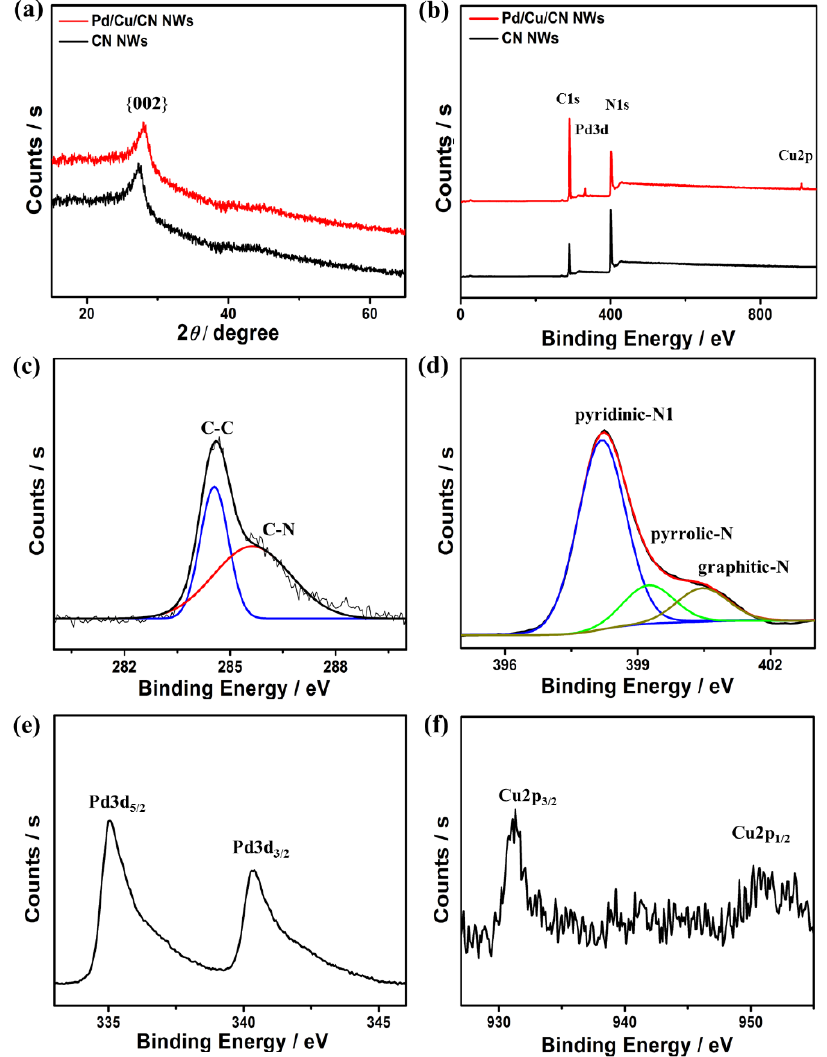
Figure 4. ( a ) Wide-angle XRD patterns; ( b ) XPS survey of Pd/Cu/CN NWs and CN NWs; ( c ) high resolution XPS spectra of C; ( d ) N; ( e ) Pd; and ( f ) Cu.